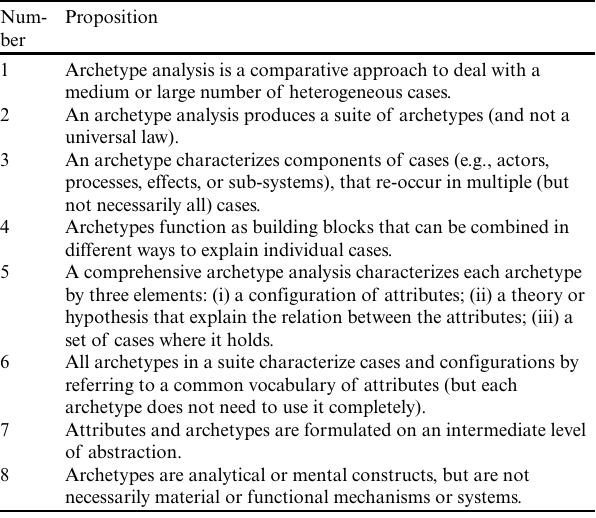
Table 1 . Core propositions on comprehensive archetype